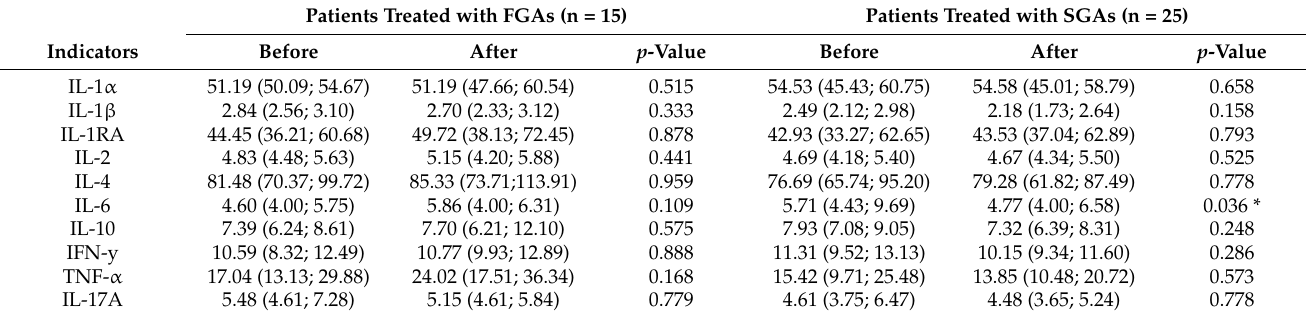
Table 3. Serum concentrations of the cytokines (pg/mL) in patients treated with FGAs and SGAs for six weeks, Me (Q1; Q3).